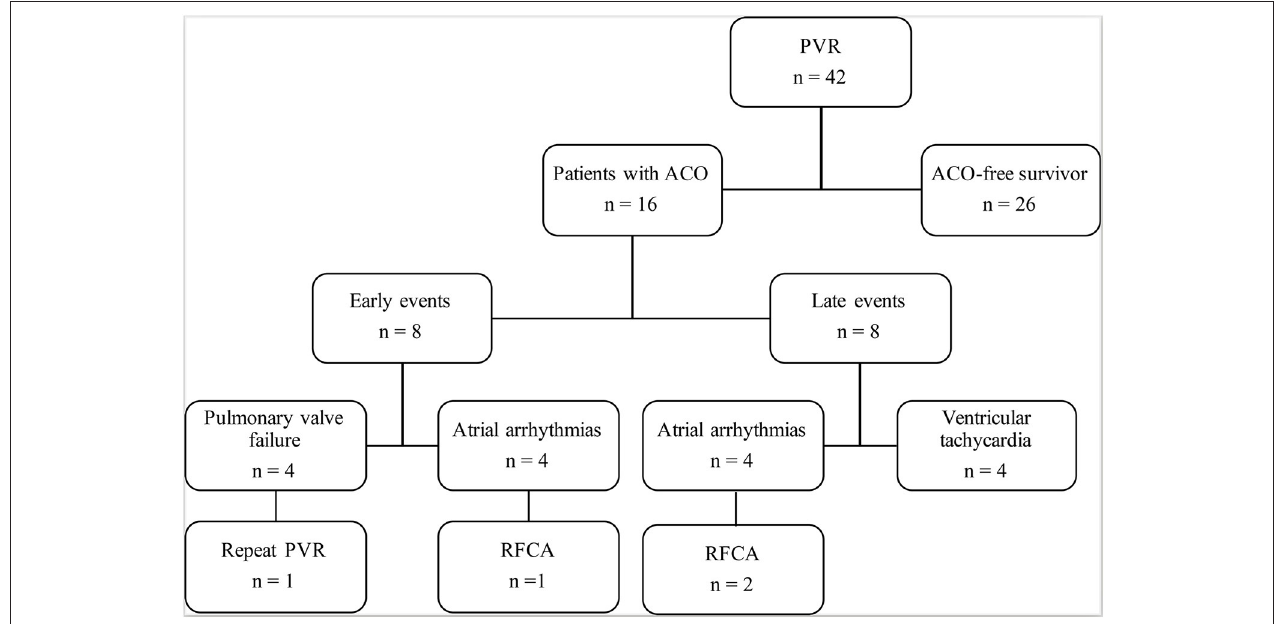
FIGURE 1 | Follow-up and outcomes after PVR. ACO, adverse clinical outcomes; PVR, pulmonary valve replacement; RHCA, radiofrequency catheter ablation.